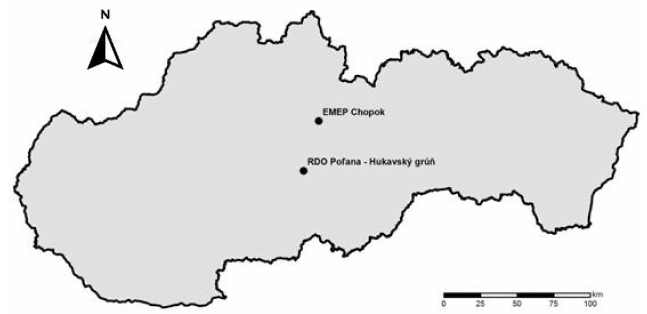
Figure 1. Location of the mountain monitoring stations EMEP (European Monitoring and Evaluation Programme) Chopok and RDO (Research Demonstration Object) Pol’ana.